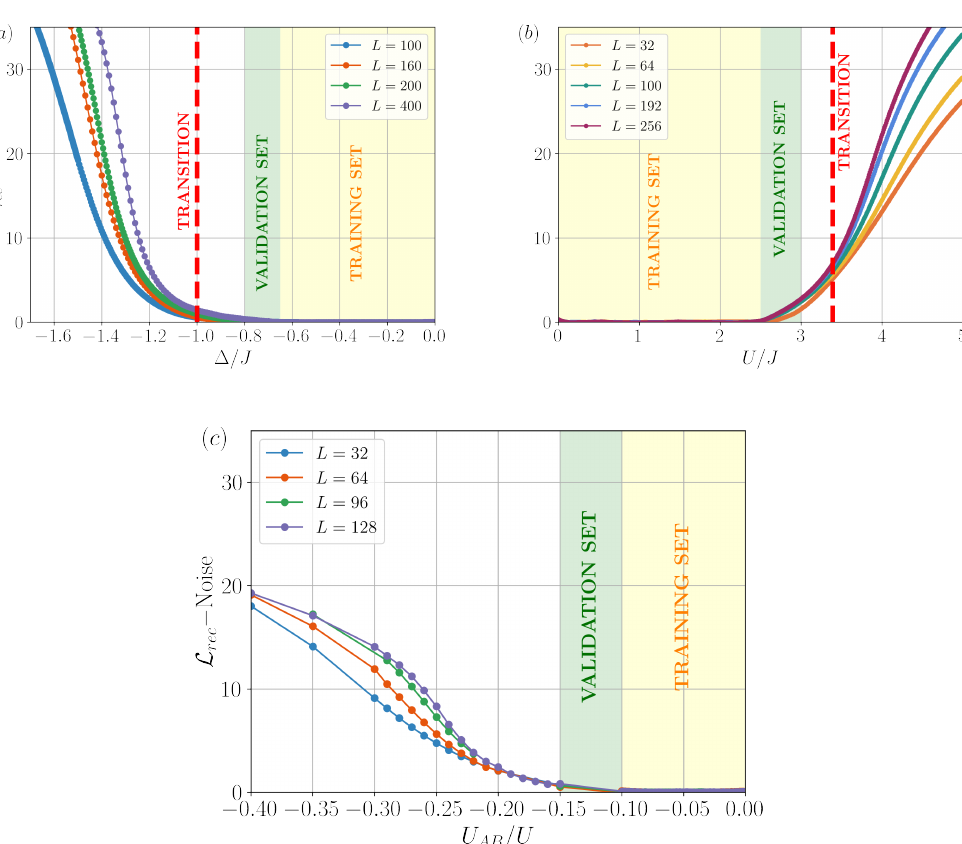
Figure 4: The reconstruction losses percentage purged of the noise as a function of the free parameters for the three models and for different sizes of the systems (indicated in the legends). The available values for the BKT transitions are reported with a dashed red line. The training sets include points in the yellow intervals whereas the validation samples are taken from the green intervals. Datasets of training samples are simulated for all the shown sizes. In ( a ) the XXZ model: all the curves show an abrupt rise in the proximity of the transition in the thermodynamic limit. In ( b ) we plot the result for the BH model. In this case the loss starts to rise after the training points but remains under the 10%, instead in the region of the transition the behaviour of the curves changes according to the size of the system. Even by changing the training window, the splitting of the curves remains very closed to the transition. In ( c ) the BH2S model for which the predicted value for the transition is still uncertain. The plot shows a trend very similar to the single species BH model. / U < − 0.2 We hypothesize that the transition should happen in the − 0.25 < U AB interval where the curves begin to separate in analogy to the previous case. This result is in good agreement with the prediction in [ 43 ]